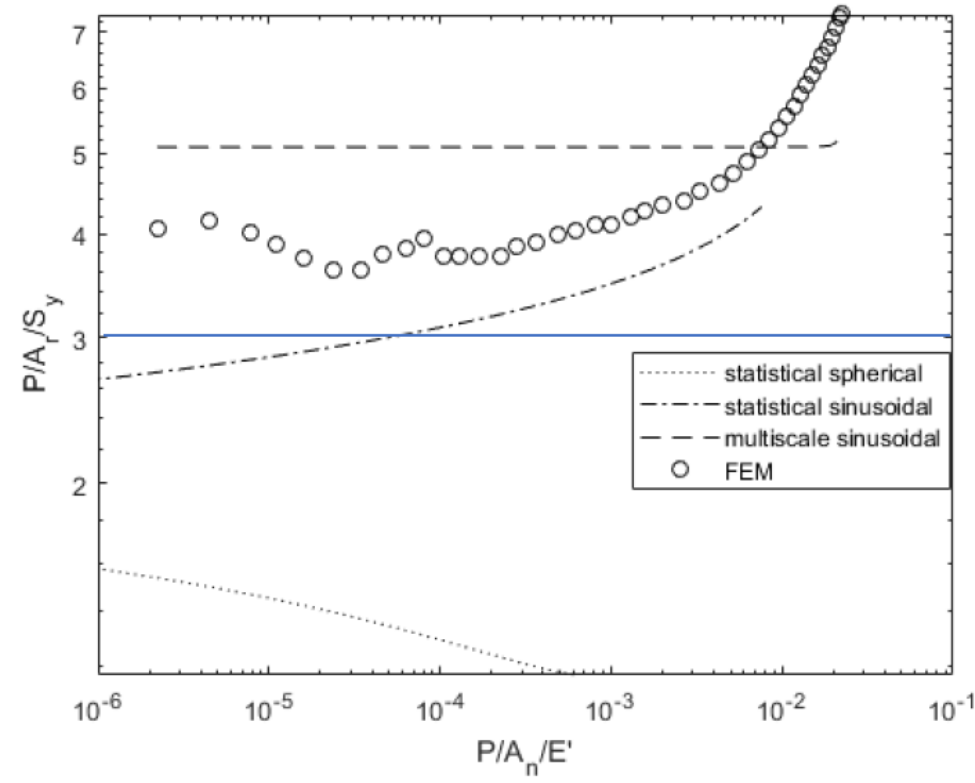
Figure 7. Load-dependent contact pressure variation for surface 4L.